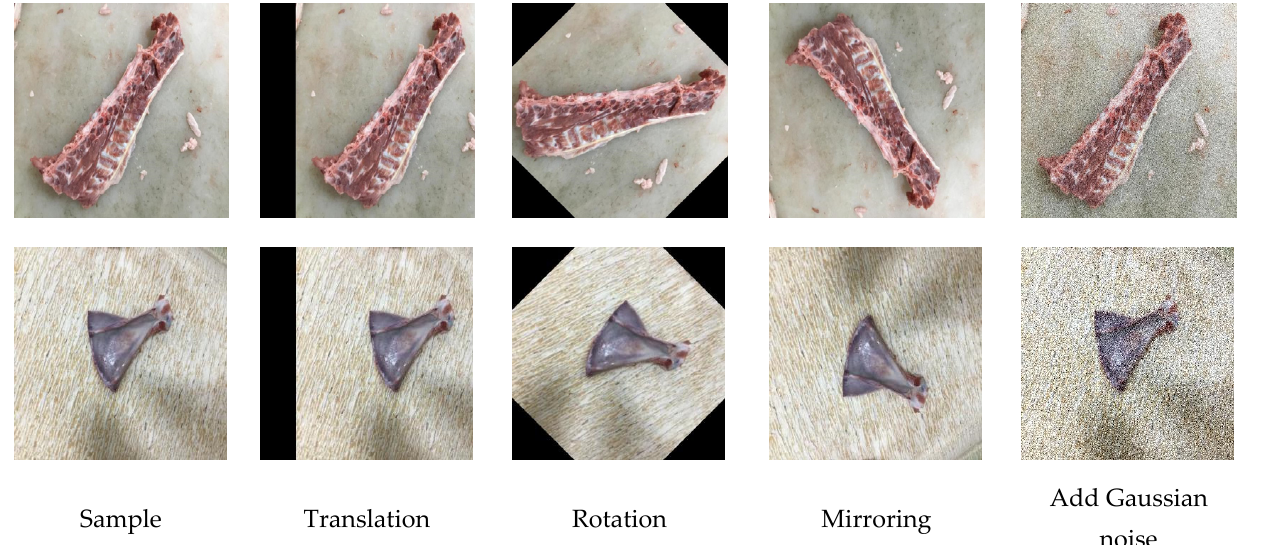
Figure 3. Enhancement of images of thoracic vertebra and scapula in mutton. After realizing image data augmentation of the sheep thoracic vertebrae and scapu- lae, a total of 12,000 mu tt on multi-part images were obtained. To reduce the complexity of the model training, the image size was scaled to 512 × 512 pixels in order to establish